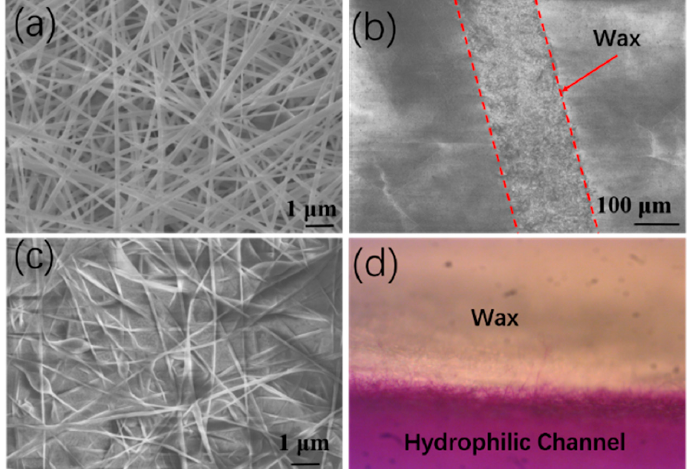
Figure 6. SEM (scanning electron microscopy) images of ( a ) a pure nanofiber membrane, ( b ) wax patterning in a nanofiber membrane, ( c ) wax-coated regions, and ( d ) optical microscopy images of dye transportation in the hydrophilic channel. No leakage to the hydrophobic region is observed.